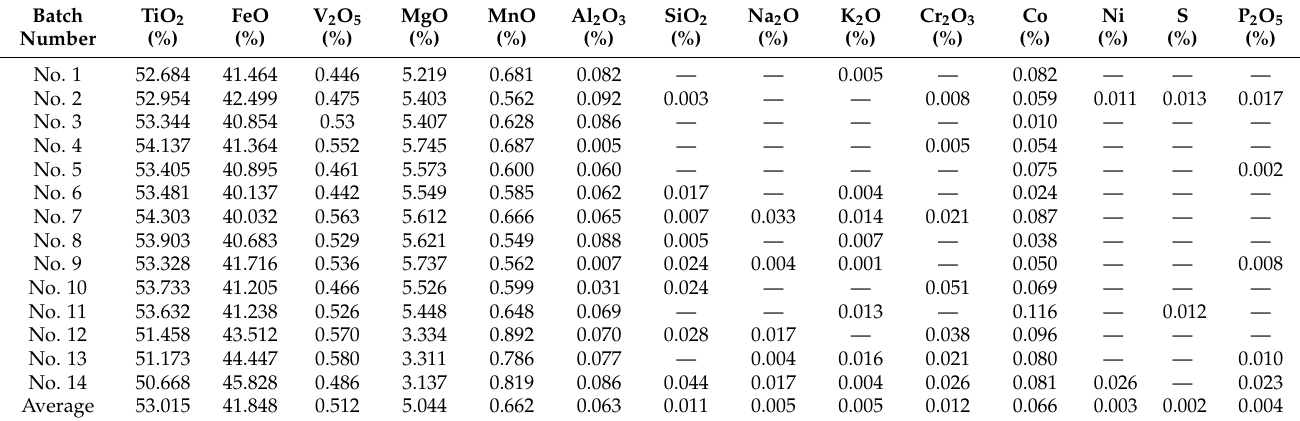
Table 5. Chemical composition of ilmenite in the different ore